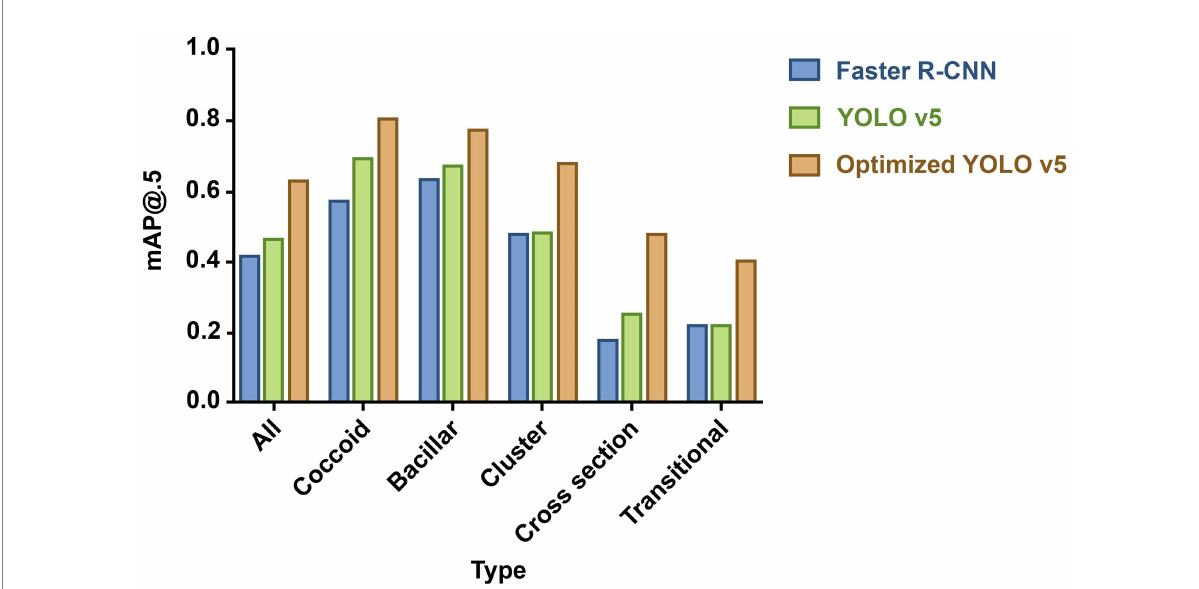
FIGURE 2 Mean average precision (mAP) for predicting different proposed bacteria detection models. The column height reflects performance: the higher the height, the better the performance. Blue column indicates Faster R-CNN; green column, YOLO v5; and orange column, optimized YOLO v5. And optimized YOLO v5 shows the best performance in detecting various morphological ( H. pylori